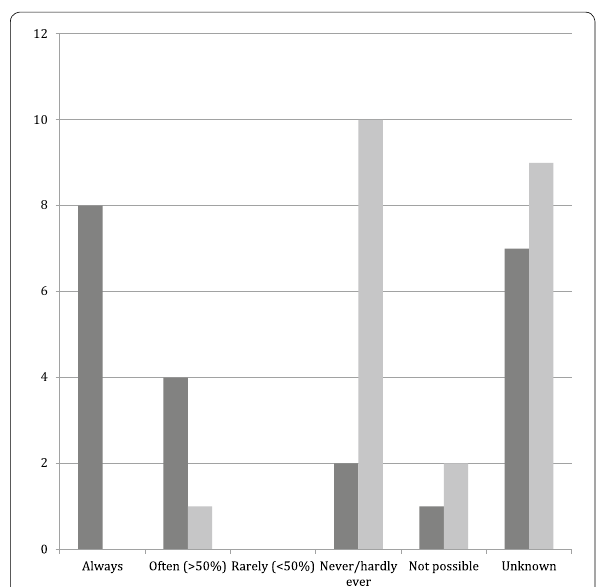
Fig. 5 Documentation. Documentation in patient charts and storage of ultrasonography images when ultrasonography is performed. Results from interviews with trauma leaders in all facilities. The graph shows the distribution of answers to two questions. Dark gray : “Are the results of the ultrasonography examination documented in the patient chart?” Light gray : “Are the images